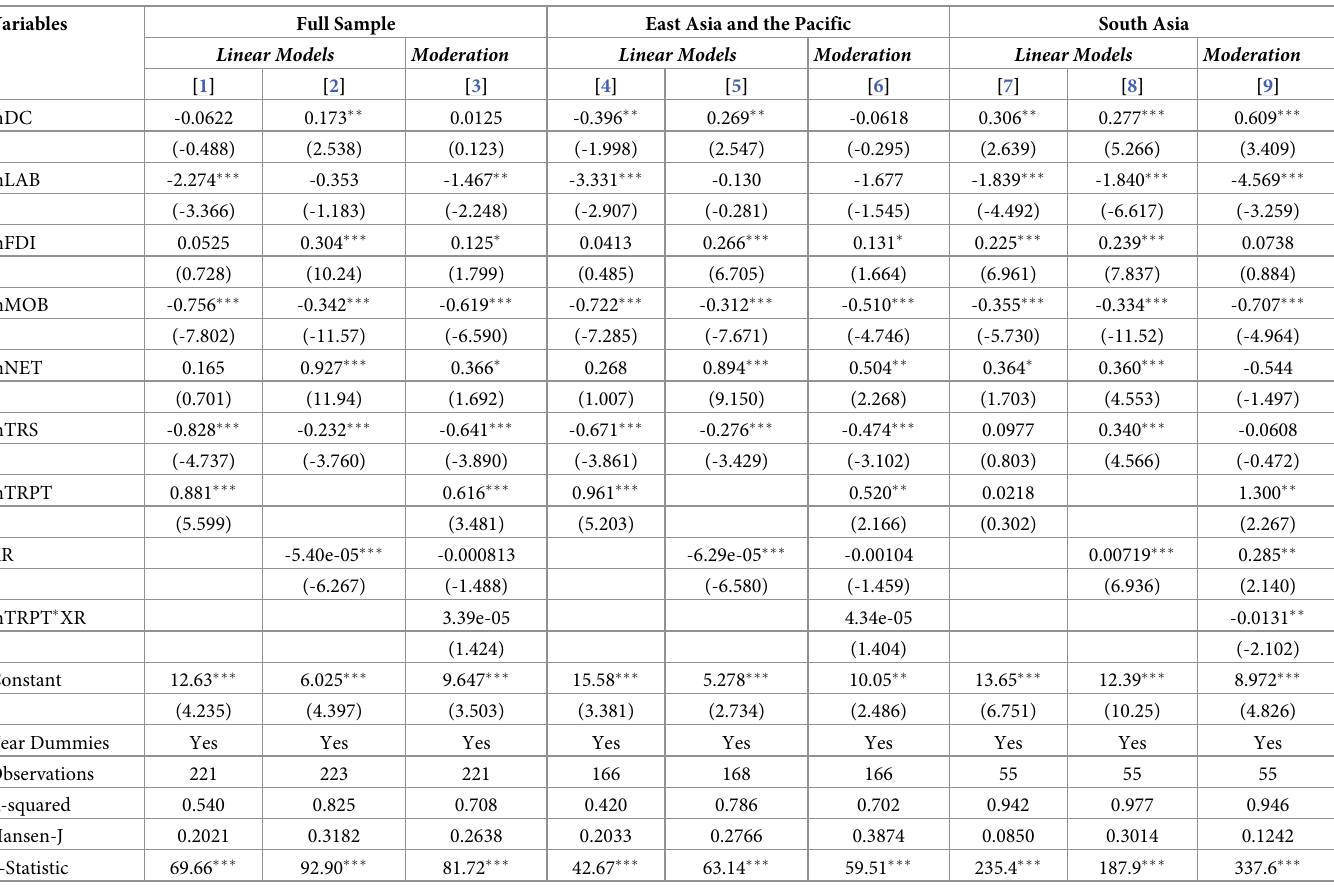
Table 3. IV-GMM results for the full and sub-samples (Dep Var: lnPC). Variables